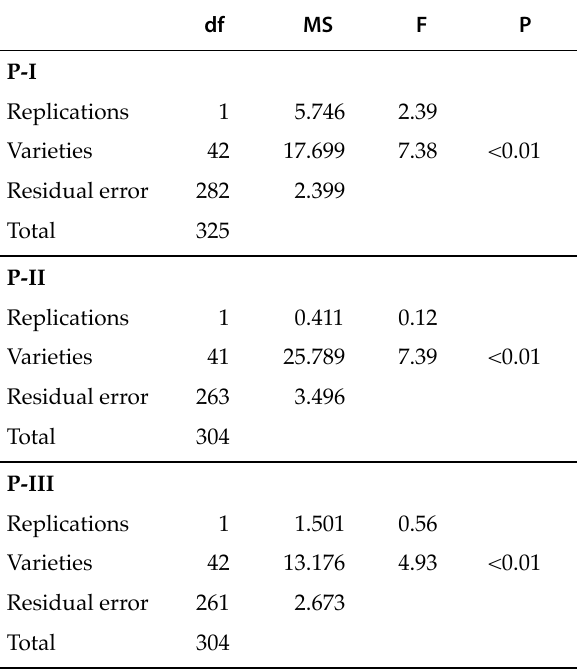
Table 2. ANOVA of the Ascochyta blight disease scale col - lected from 43 chickpea genotypes across two replications, against P-I, P-II, and